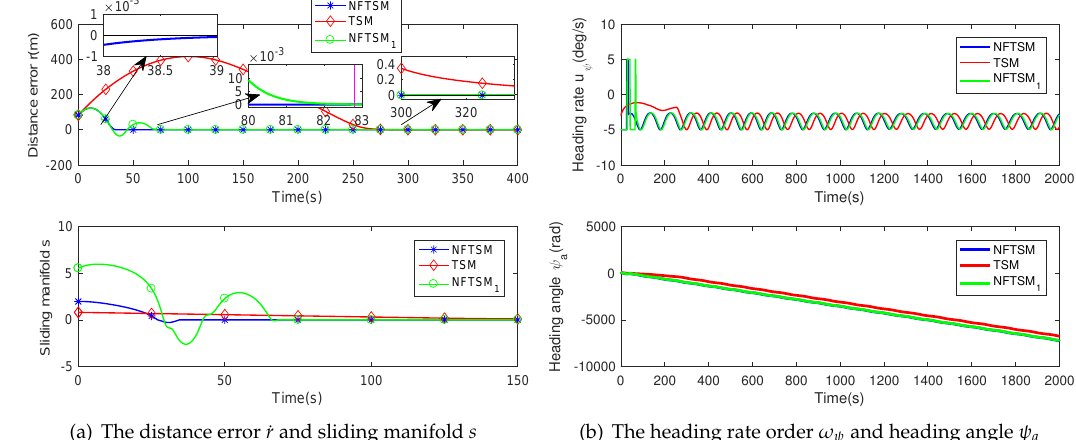
Figure 8. The result of tracking a moving target along the S-shape